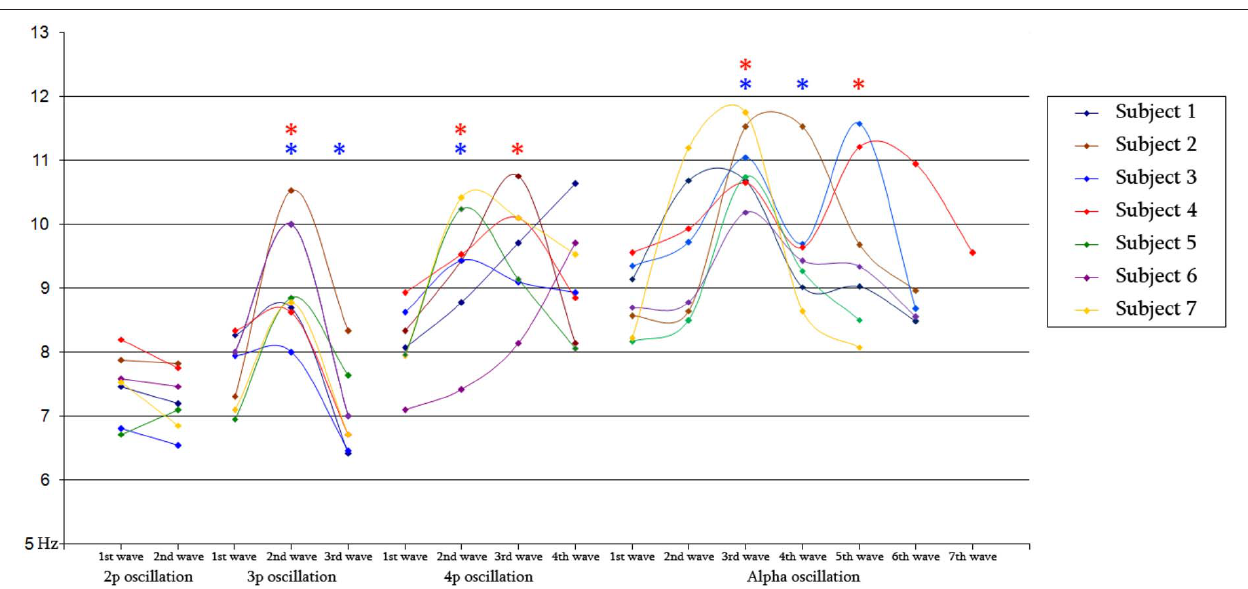
subjects. Blue and red stars denote a statistically significant change of mean instantaneous frequency compared to that of the preceding wave and that of the 1st wave,